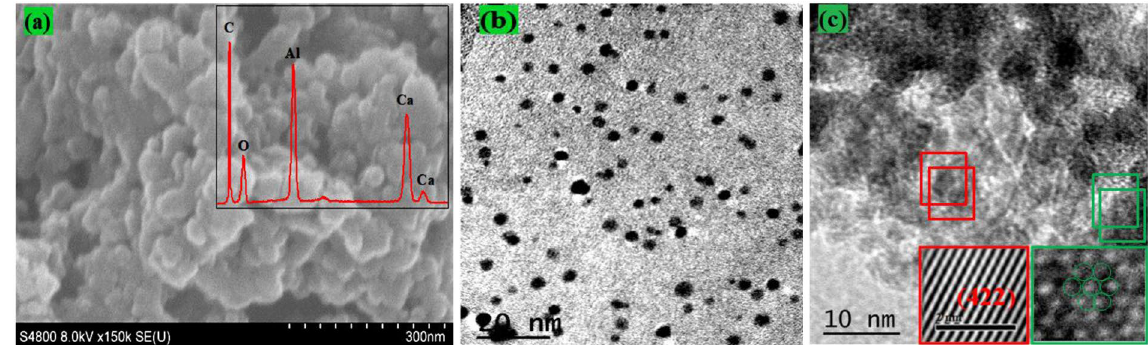
Figure 5. ( a ), SEM, and ( b ), TEM/HR-TEM images of C 12 A 7 − x Fe x :e − , where doping level, x = 1.